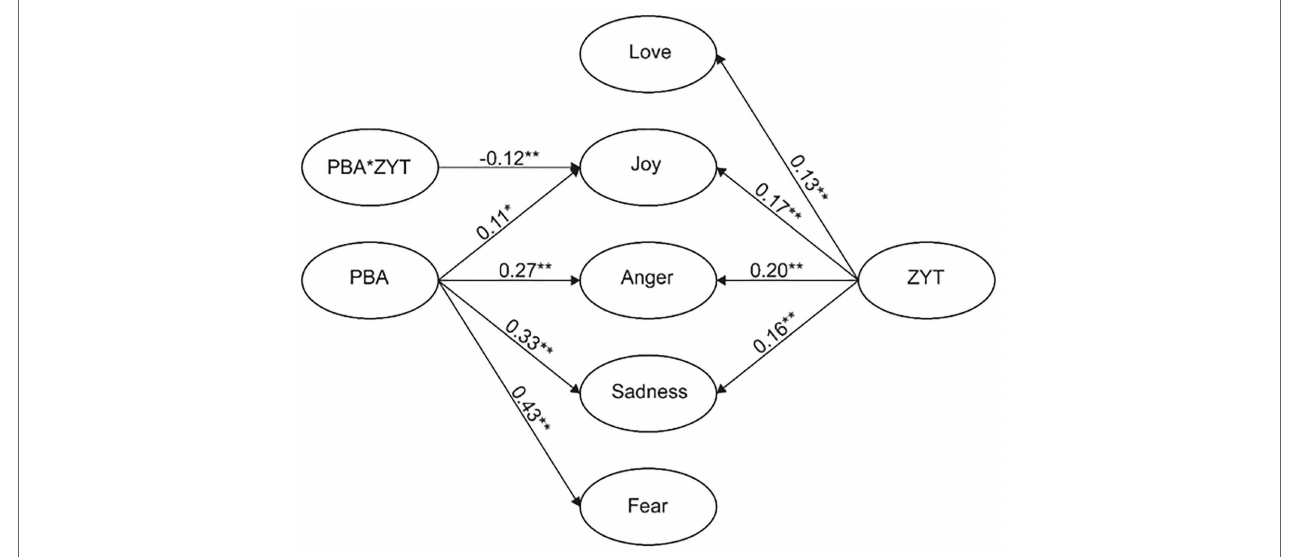
FIGURE 2 | Structural model results showing the moderation effect of ZYT on the relationship between PBA and teacher emotions. PBA refers to performance- based accountability, ZYT refers to zhongyong thinking, and PBA * ZYT refers to the interaction of PBA and ZYT. All the reported parameters are standardized. The insignificant path and controlled variables are not shown in the figure. * p < 0.05; ** p < 0.01.